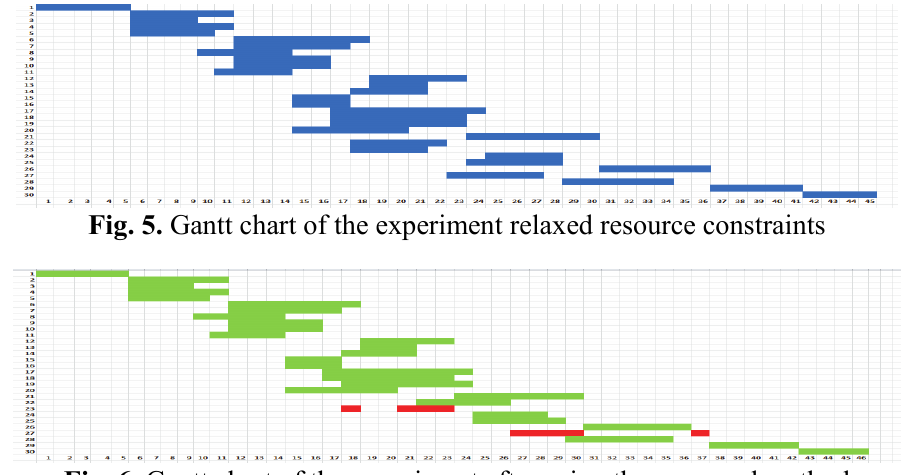
Fig. 6. Gantt chart of the experiment after using the proposed method